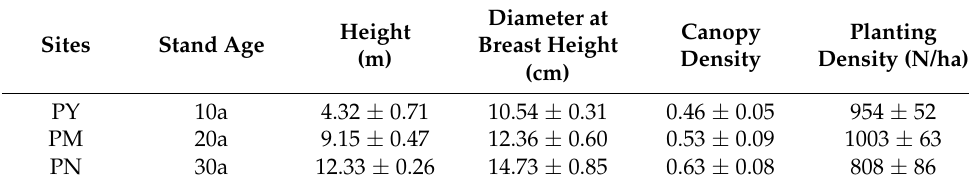
Table 3. Description of the sampling sites. Sites Stand Age